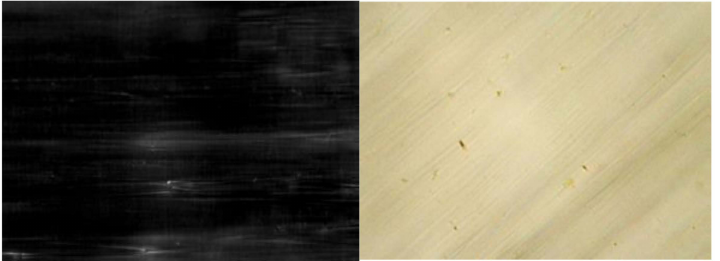
Figure 9. Micrographs of textures of a planar-aligned 107- µ m thick layer of the FLC-618 helical nanostructure ( p 0 = 105 nm) in a polarizing microscope, image size 250 µ m × 200 µ m. Dark field on the left: the axis of the FLC helix is directed along the plane of the polarizer of the microscope, i.e., β = 0 ; the bright field on the right when the axis is at the angle of β = 45 ◦